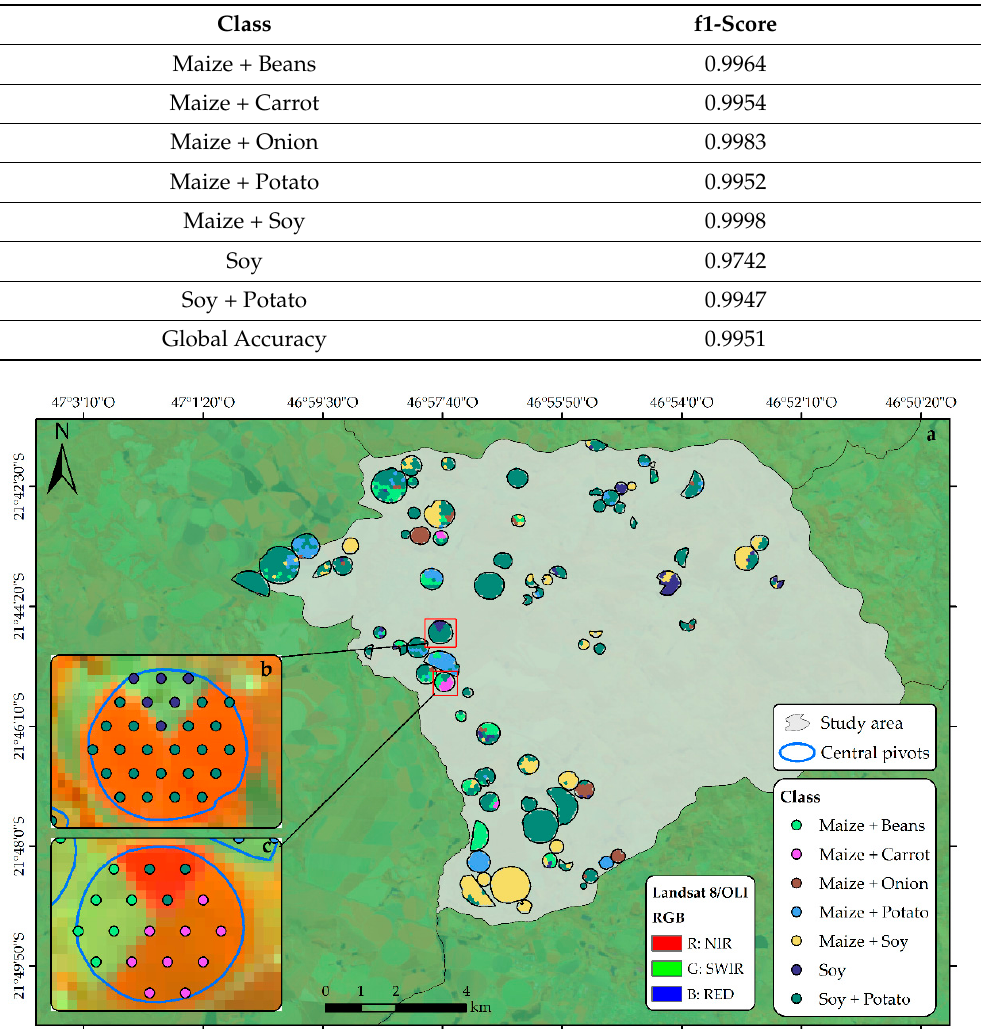
Figure 8. ( a ) Classification result in the municipality of Itobi, SP, for the 2015/2016 agricultural year. Details of the crop variability within center pivots are illustrated in figure ( b , c ).